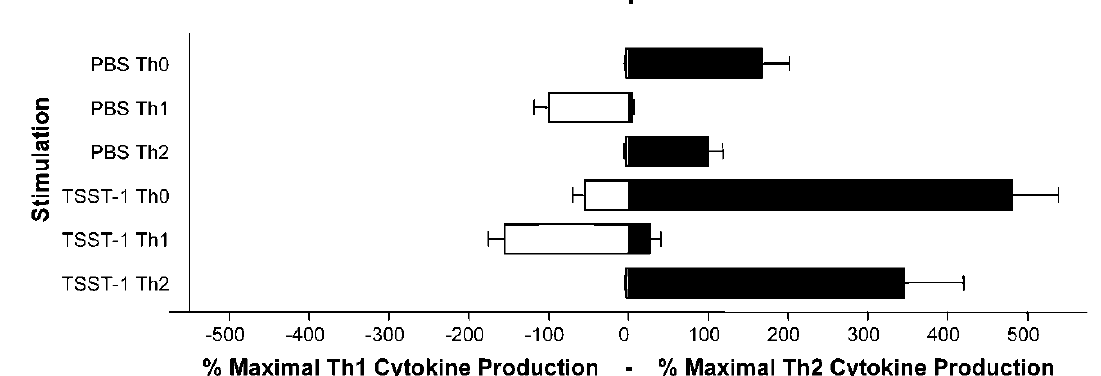
FIG. 5. Relative cytokine production, T h 1 versus T h 2. IFN- g production is made relative by first dividing production values by the mean IFN- g concentration following T h 1 polarisation of CD4 (cid:2) T cells from invivoPBS-treated mice, and then expressing this as a percentage. Relative T h 2 polarisation is assessed by dividing IL-4 production values by the mean IL-4 concentration following T h 2 polarisation of CD4 (cid:2) T cells from in vivo PBS-treated mice, and then expressing this as a percentage. T h 0 stimulation of CD4 (cid:2) T cells from PBS-treated mice clearly shows the BALB/c strains bias towards a strong T h 2 response. T h 1 and T h 2 stimulation of the CD4 (cid:2) T cells from the PBS-treated mice demonstrates the relative 100% maximal production of IFN- g and IL-4, respectively. CD4 (cid:2) T cells from mice treated repeatedly with TSST-1 have both an enhanced T h 1 and T h 2 response under non-polarising T h 0 stimulation conditions, compared with T h cells from mice treated with PBS. There is a 480% of maximal increase in IL-4 production, while the production of IFN- g is low at 58% of maximal. T h 1 polarisation of the CD4 (cid:2) T cells derived from the TSST-1 repeatedly treated mice demonstrates that, despite strong T h 1 polarisation, there is a difference in IL-4 production under this stimulatory condition, indicating that despite strong T h 1 polarisation cells are still actively producing IL-4, indicating a shift to the T h 2